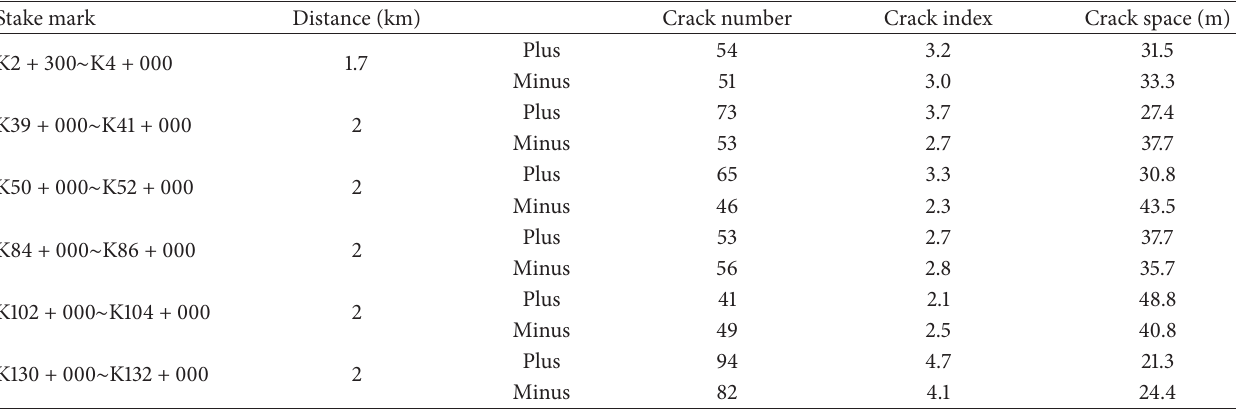
Table 8: Surveyed data of thermal cracking on Qitai Highway after 6 months since traffic opening.